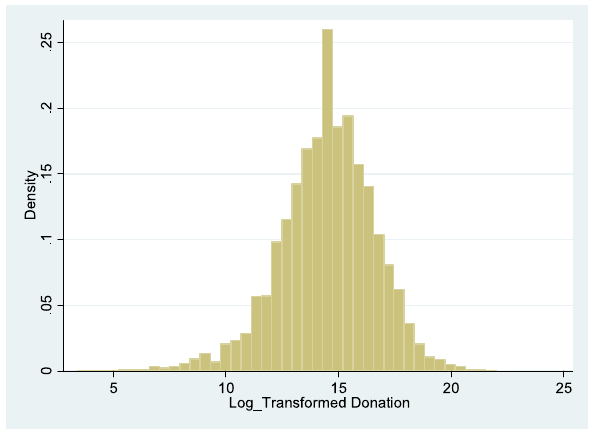
Figure 2: The histogram of the log-transformed